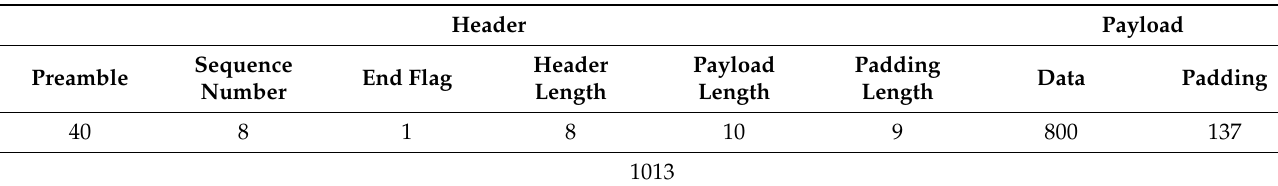
Table A1. Structure and length of the transmitted frame in